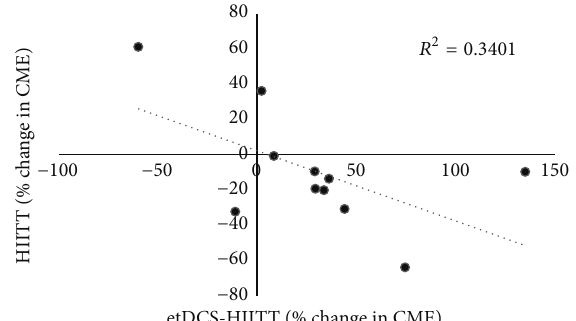
Figure4:Relationshipbetweenpercentagechangesincorticomotor excitability of the paretic tibialis anterior muscle between the two sessions for all participants. Dashed line represents the negative linear relationship ( 𝑅 2 = 0.34 , 𝑝 = 0.05 ) suggesting that those who were facilitated during e-tDCS+HIITT showed the most inhibition during HIITT